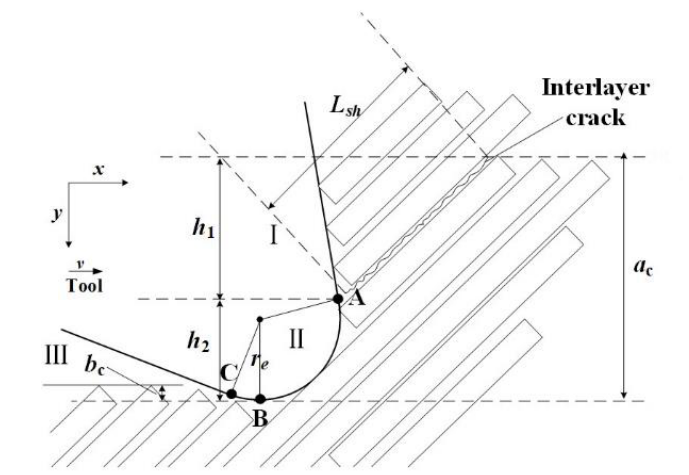
Figure 9. Schematic illustration of the CFRP cutting process. The tip of the tool is surrounded by fibers, some already broken. The zones of slip (I), fracture (II), and rebound (III) are clearly visible. The depths a c , h 1 , and h 2 are defined in the drawing.